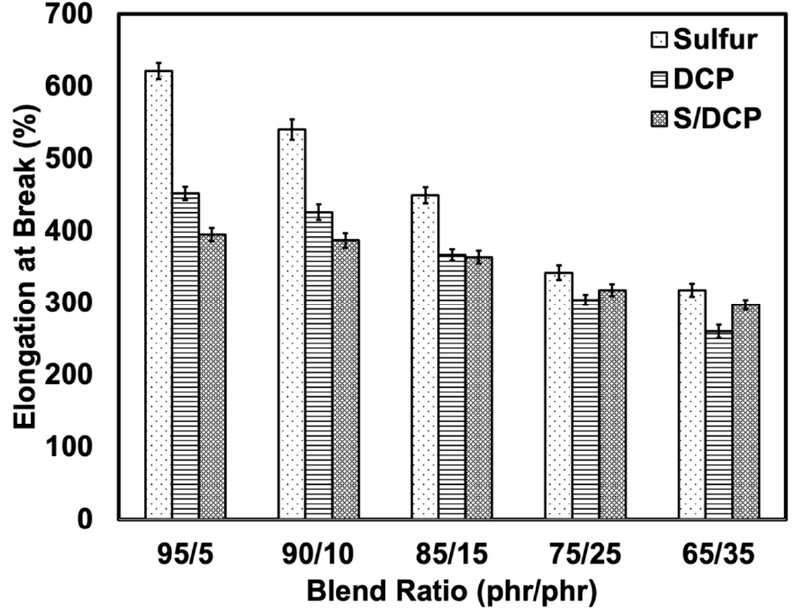
Figure 5. Elongation at break of NR/r-NBR blends with various crosslinking systems.